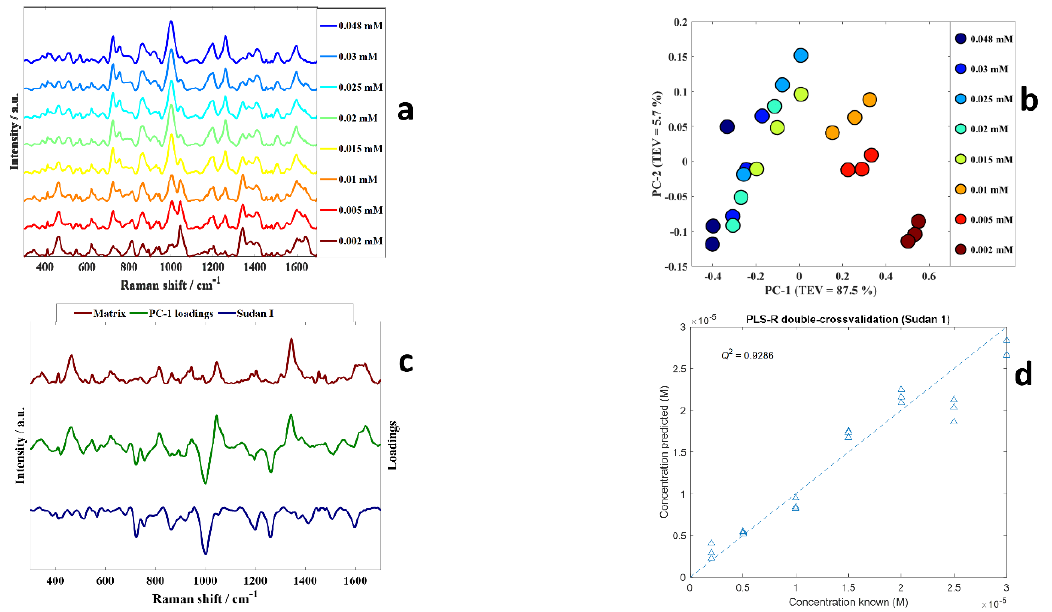
Figure 3. ( a ) SERS spectra of Sudan I shows different concentrations and spectra are offset for clarity; ( b ) PCA scores plot from SERS spectra from Sudan I, the colours represent the concentrations, and the details are provided within the figure; ( c ) PC1 loadings plot (green), matrix (aggregation agent (0.5 M NaCl) and gold nanoparticles) (brown), and Sudan I (blue, multiplied by − 1 (i.e., inverted) for clarity); ( d ) PLS − R predictions of Sudan I, these models used double-cross validation .